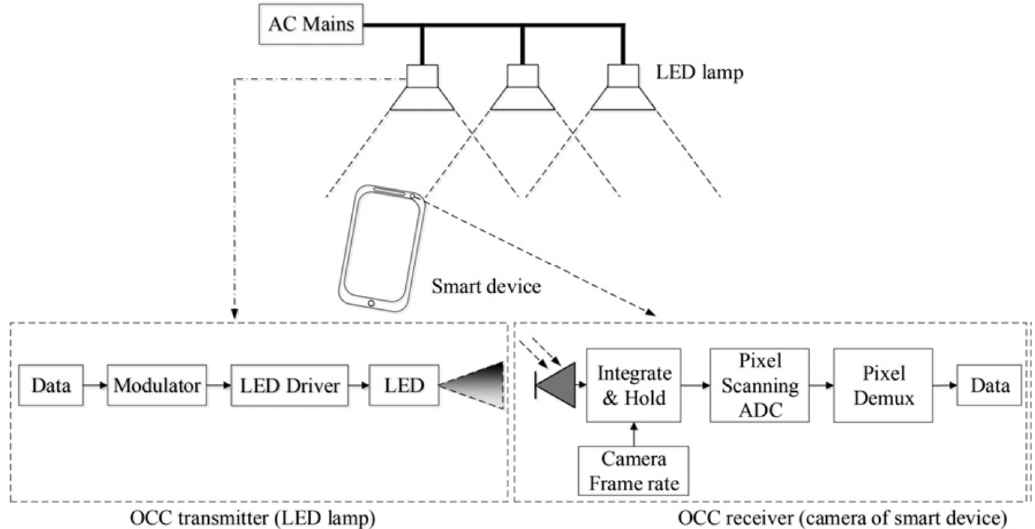
Figure 2. A schematic view of the optical camera communication (OCC) system.